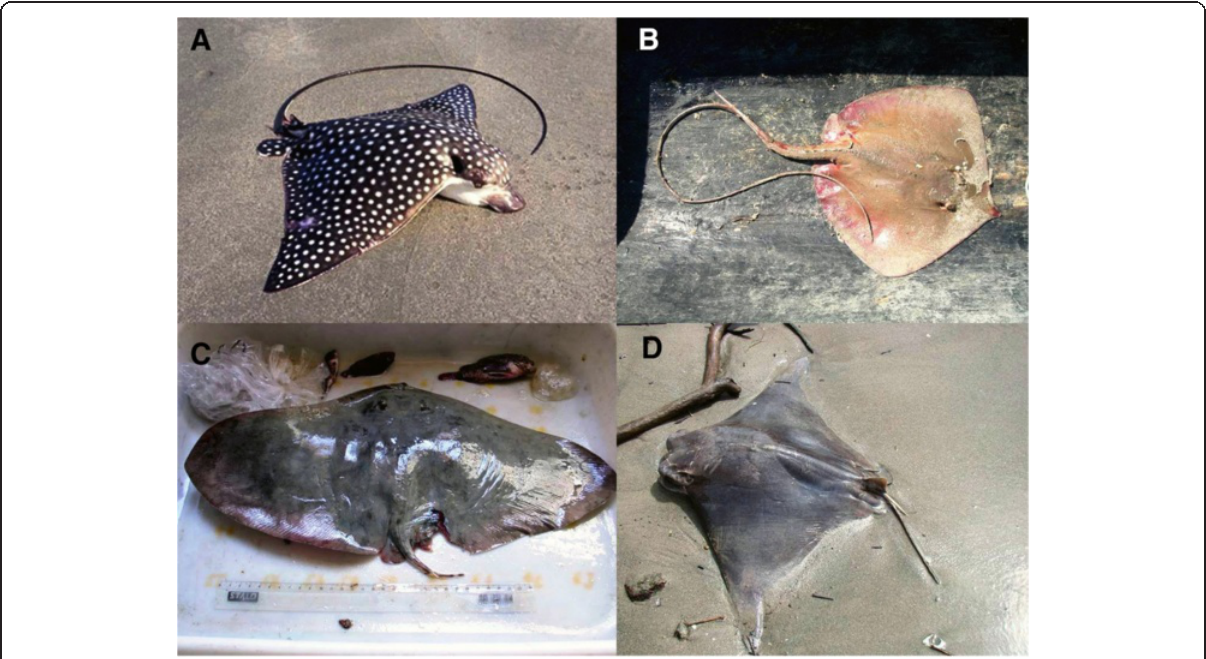
Figure 2 Genera of marine stingrays. (A) Aetobatus narinari , the spotted stingray; (B) Dasyatis guttata , the whiptail ray; (C) Gymnura sp., the butterfly or butter ray; (D) Rhinoptera bonasus , the cownose stingray. Photos by: Ivan Sazima and Vidal Haddad